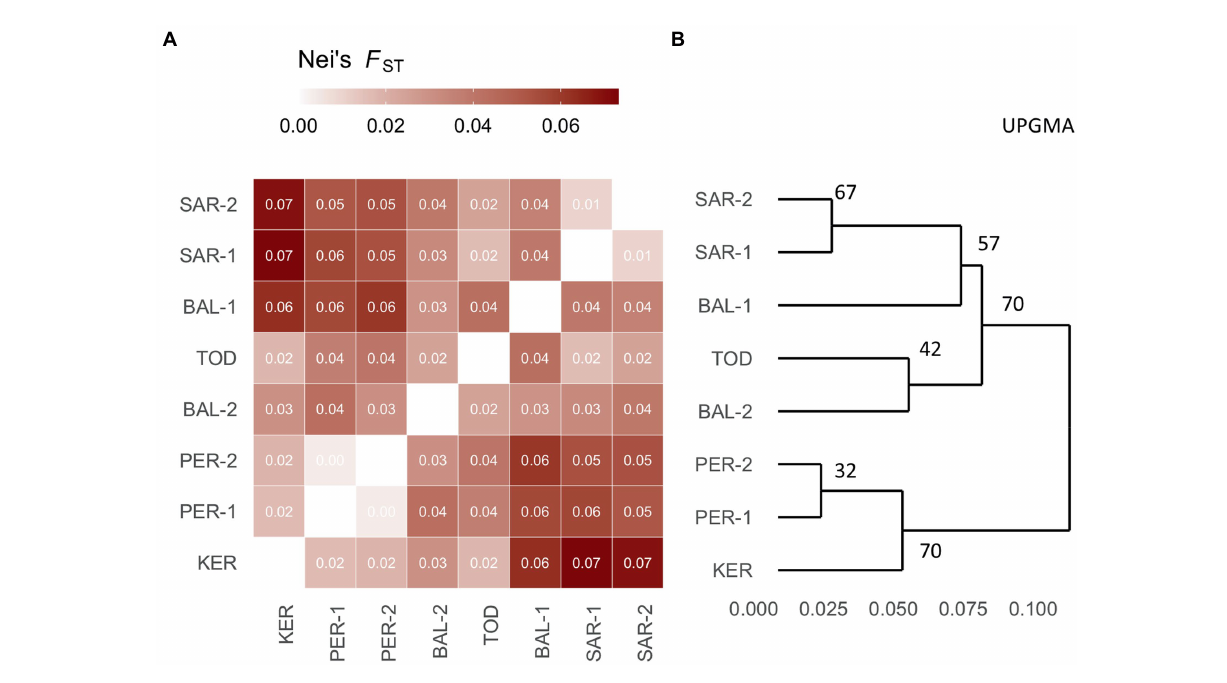
FIGURE 2 Heatmap of pairwise F st (Nei, 1978) values (A) and bootstrapped UPGMA tree (B) of the eight Scots pine populations